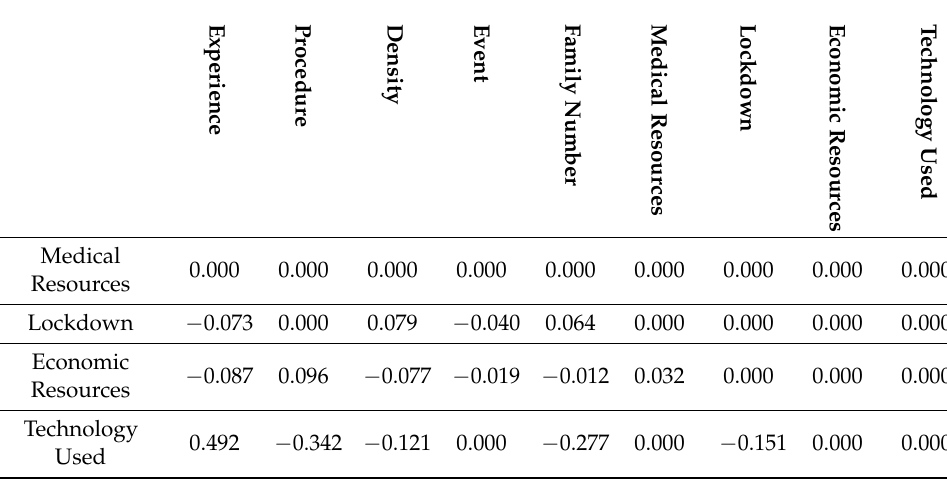
Table 10. Standardized indirect effects of exogenous variables on endogenous